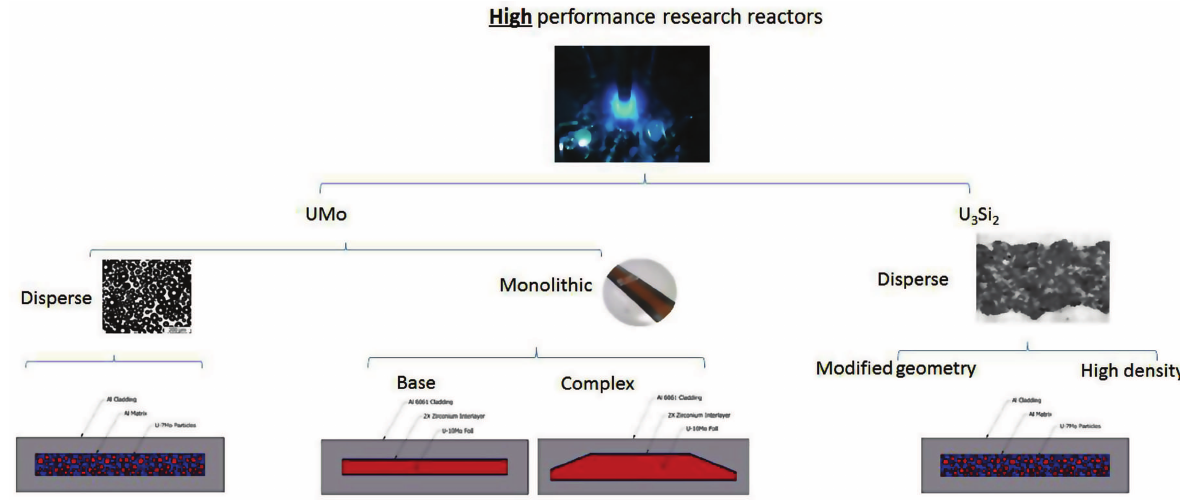
Fig. 2. Fuel system fabrication routes studied in LEU-FOREvER and